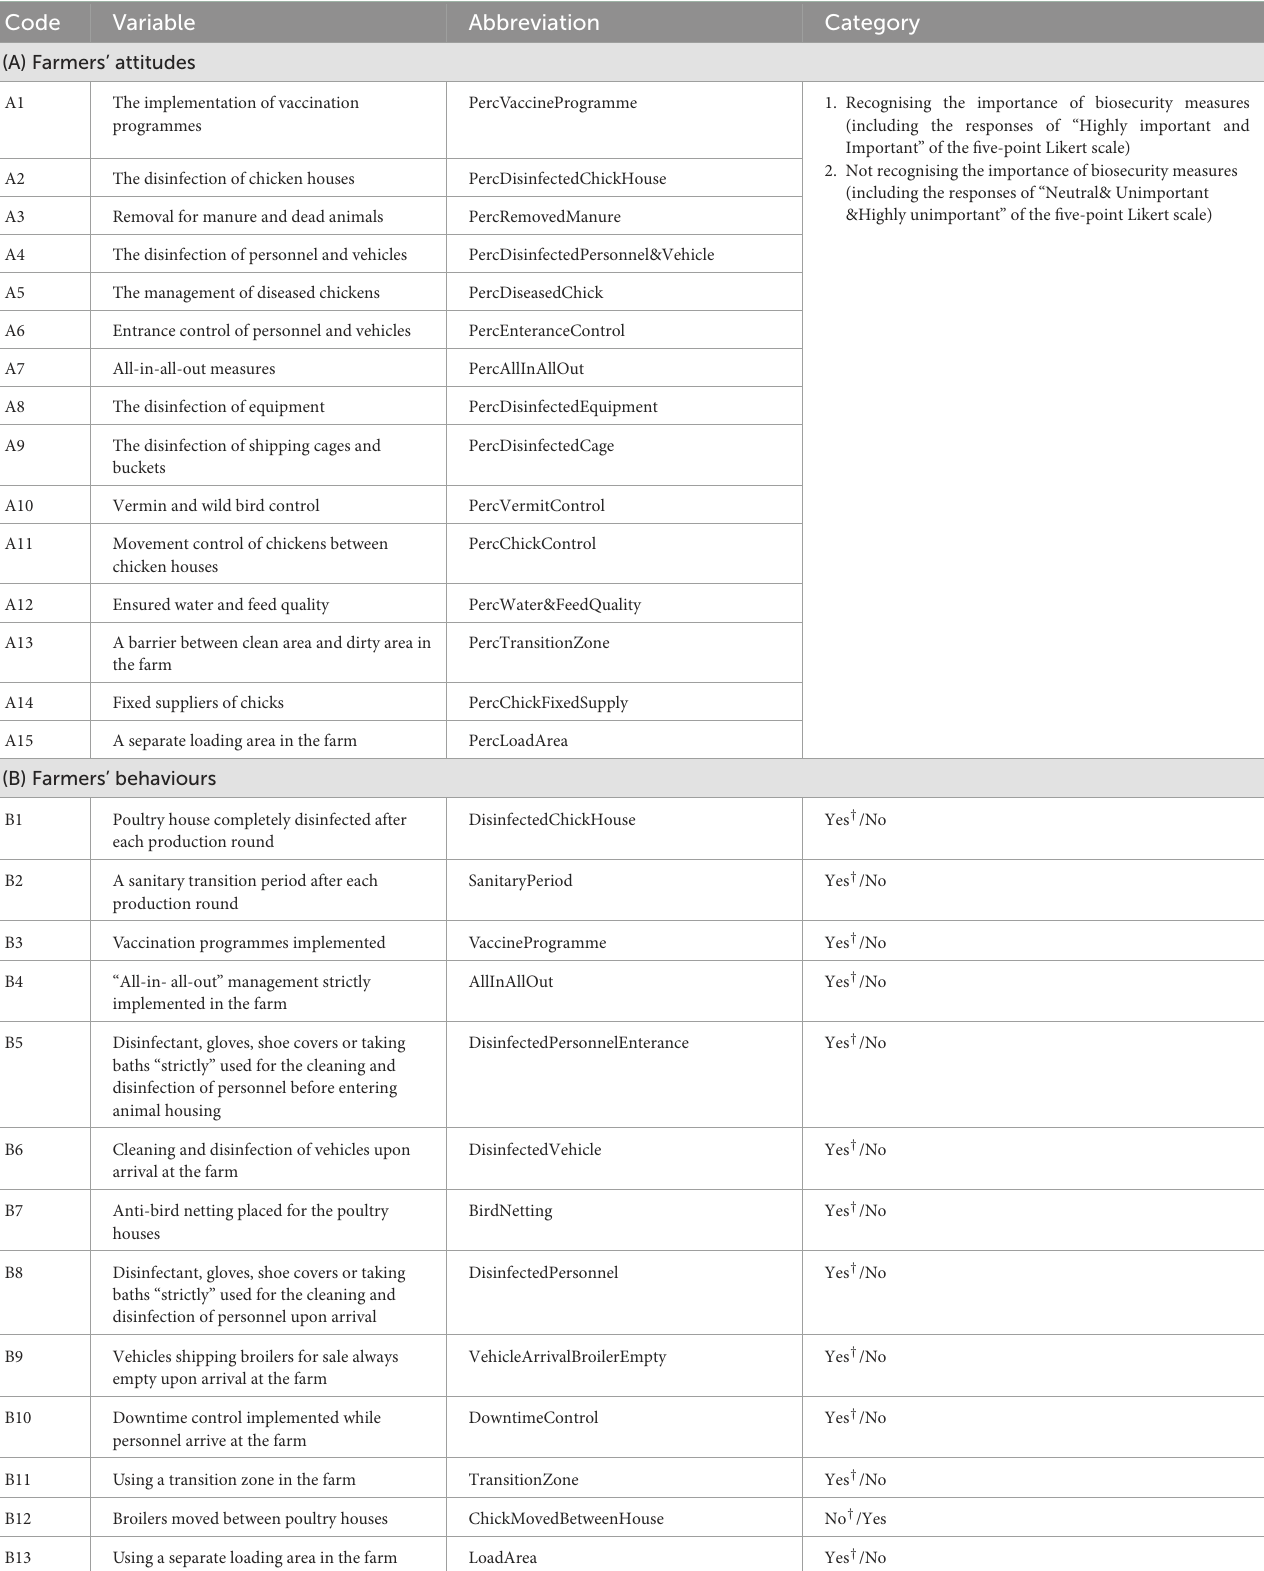
TABLE 2 Descriptive statistics of farmers’ attitudes and behaviours in relation to biosecurity ( n = 303).